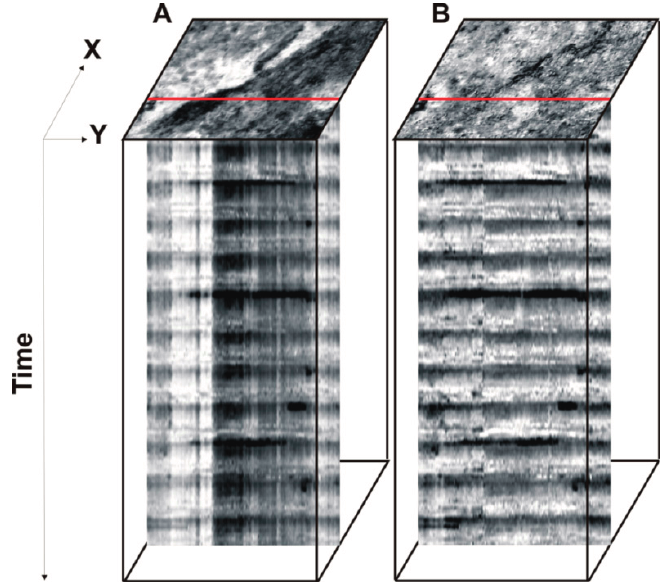
Figure 11. Original ( A ) and standardized time-series ( B ) images and its respective horizontal slice